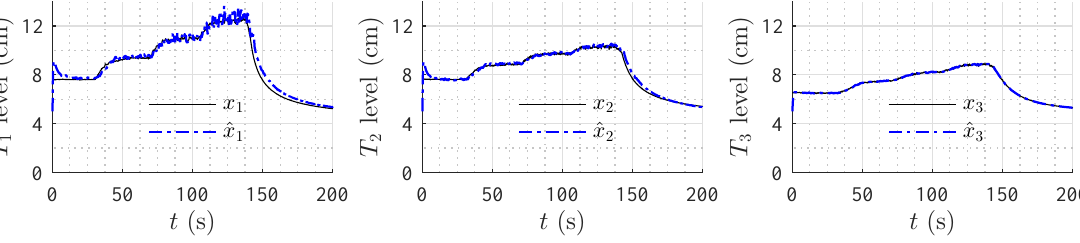
Figure 11. HGO experimental results: rectangular weir at T 2 and linear weir at T 3 , k = [ 1.2,0.5,0.1 ] T .